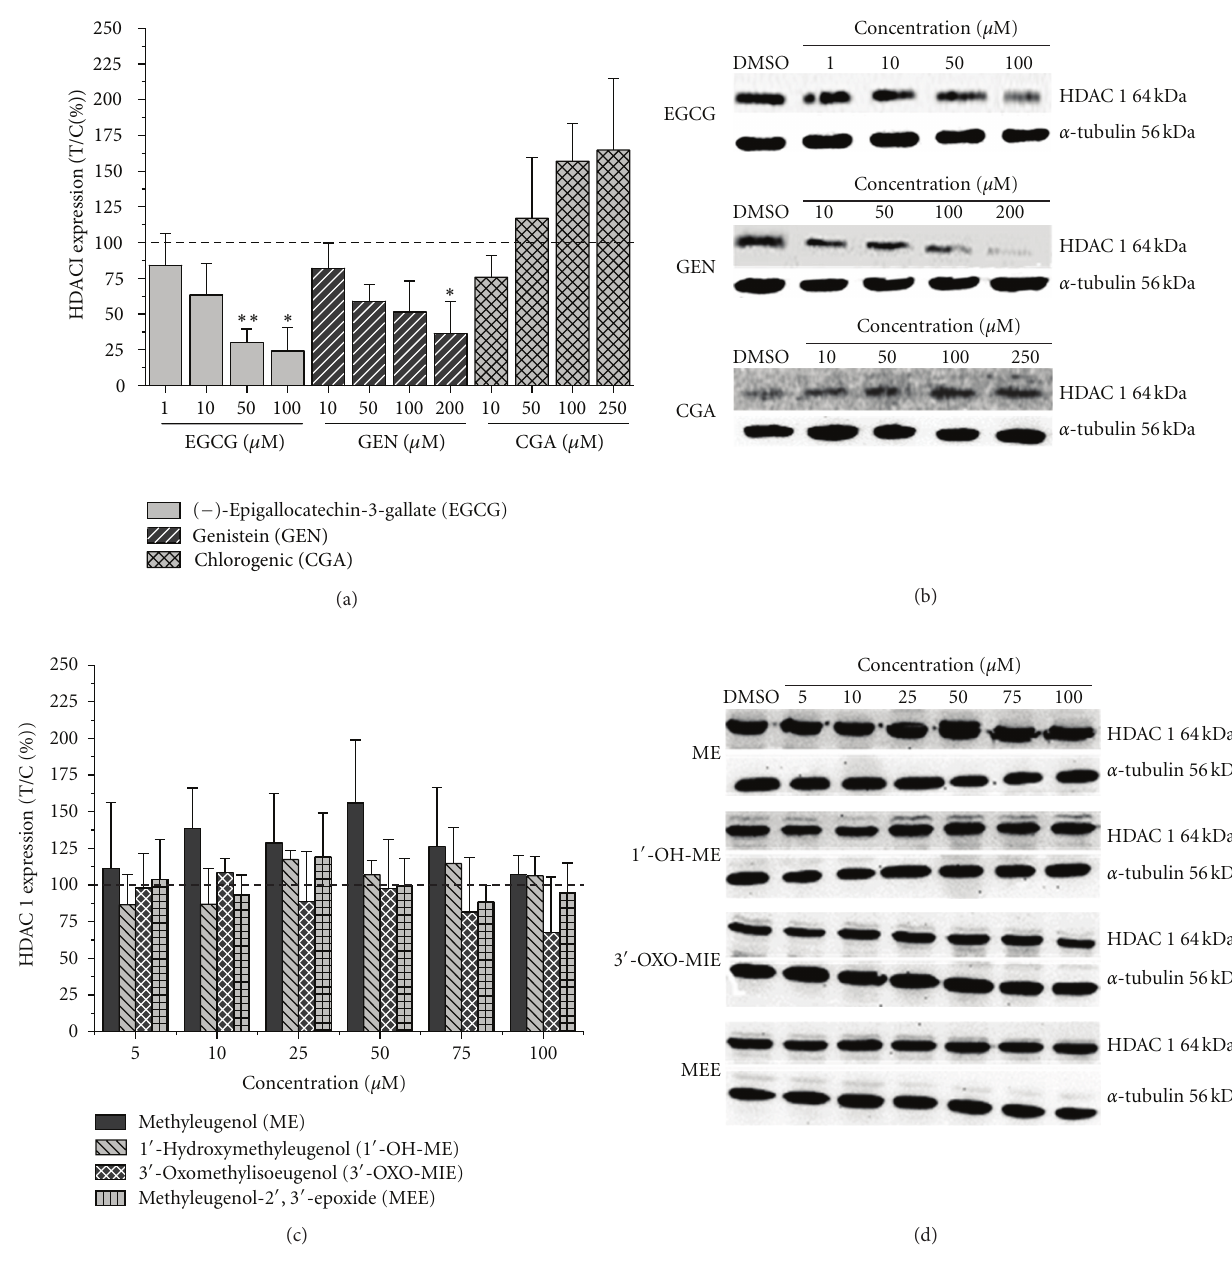
Figure 4: Western blot analysis and representative western blots of HDAC1 expression in HT29 cells after 24 h treatment with polyphenols in the presence of catalase (100U/mL) ((a) and (b)) or methyleugenol and respective metabolites ((c) and (d)). DMSO: solvent control (0.5% v/v), 𝛼 -tubulin: loading control. Arbitrary light units were plotted as test over control [%], with the respective solvent control (0.5% v/v DMSO) set to 100%. The presented data are mean ± SD of four independent experiments with similar outcome. The significances indicated were calculated in relation to the lowest applied concentration (Student’s 𝑡 -test: ∗ 𝑃 ≤ 0.05 ; ∗∗ 𝑃 ≤ 0.01